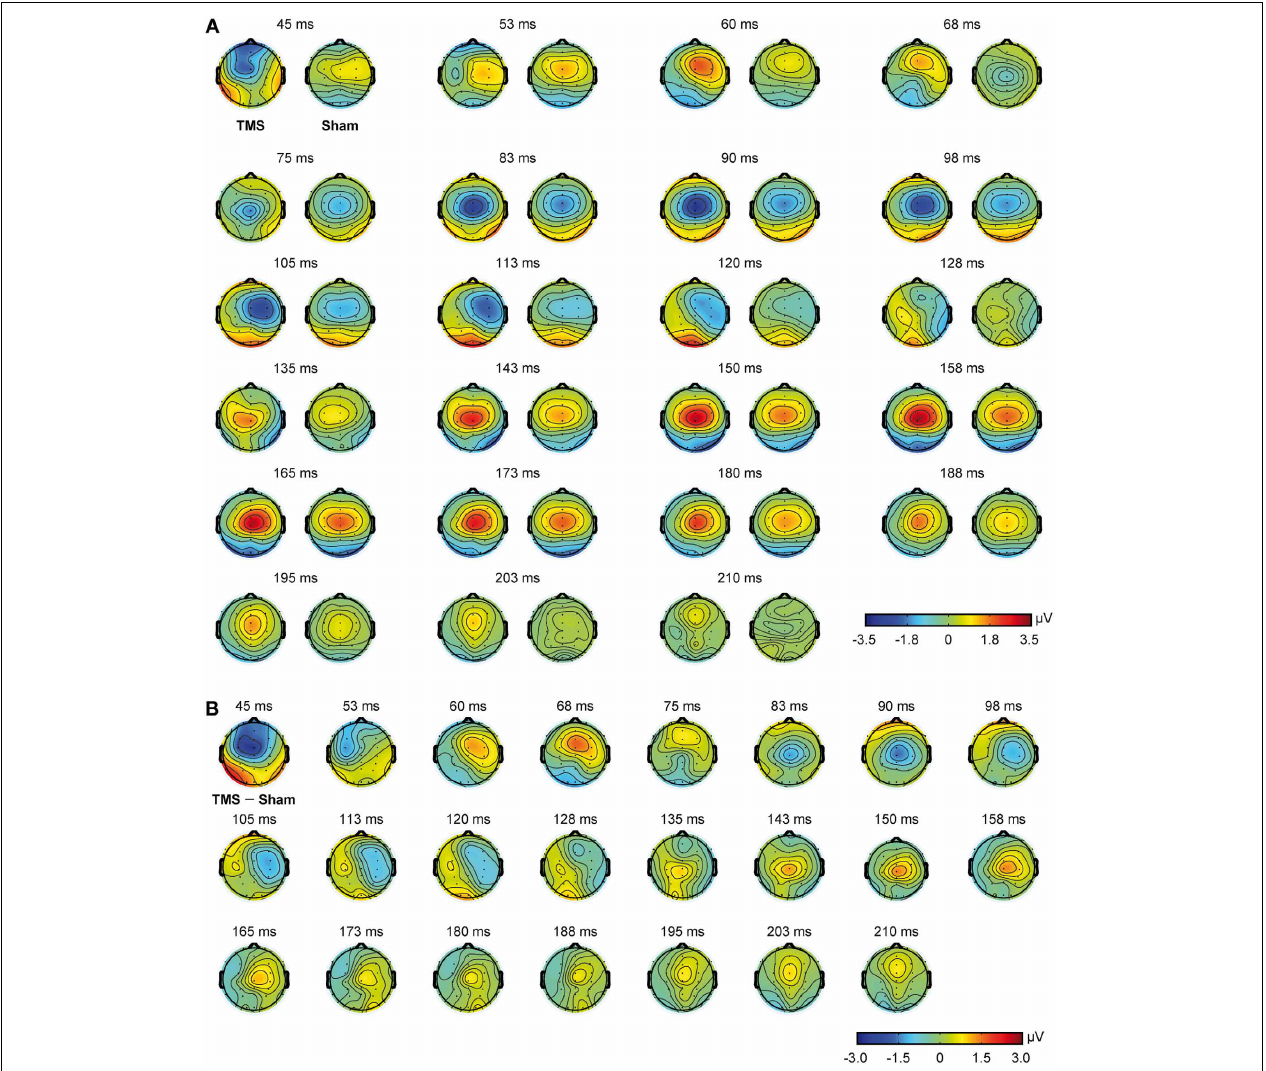
FIGURE 3 | Scalp topographies obtained from real TMS and sham conditions. Real TMS scalp topographies are shown on the left and sham topographies on the right (A) . Scalp topographies obtained from the direct comparison of real TMS and sham conditions are also shown (B)